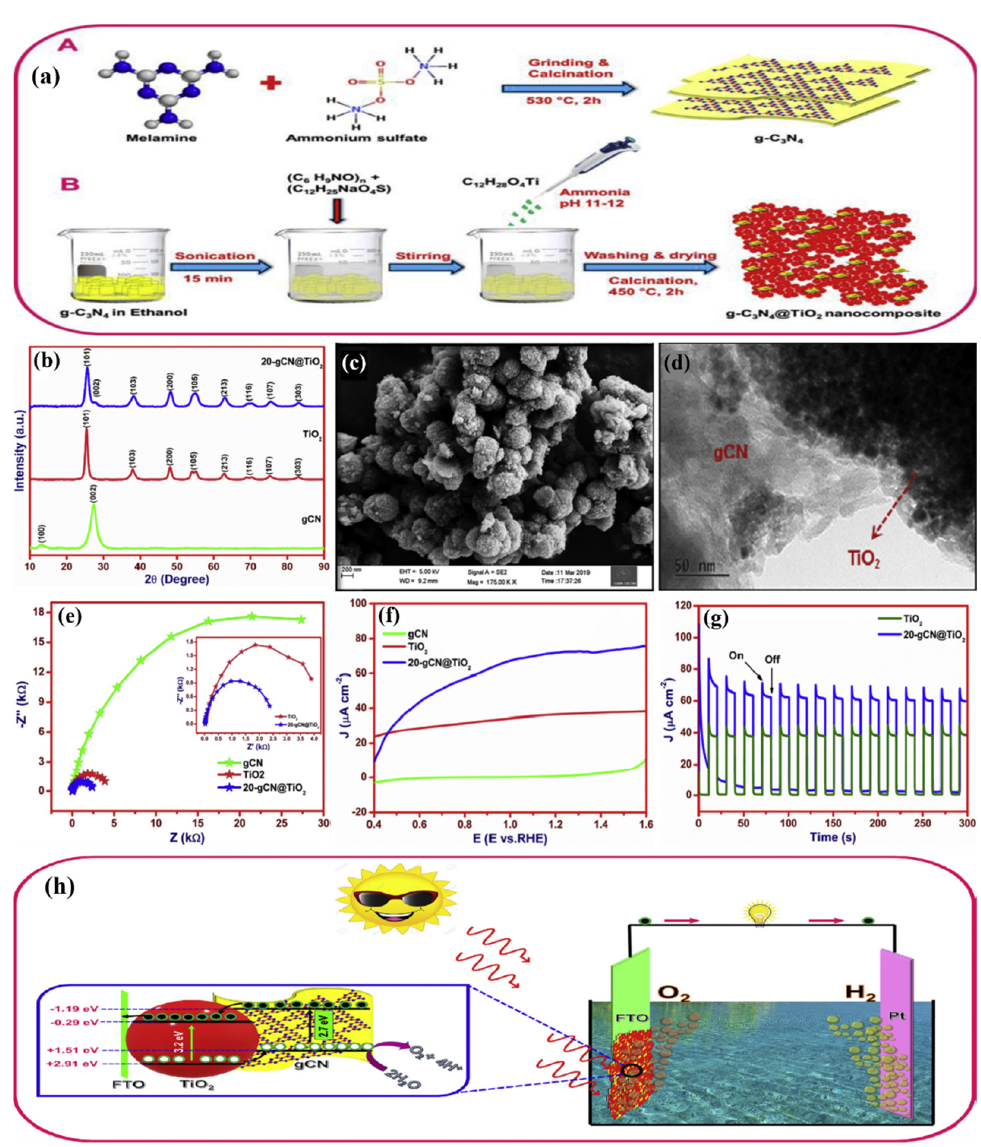
Figure 5. ( a ) Formation mechanism of CN@TO heterostructured material, ( b ) XRD patterns, ( c ) SEM image of 20-CN@TO material, ( d ) TEM image of 20-CN@TO material, ( e ) Nyquist plots, ( f ) LSV curves, ( g ) I-t curves, and ( h ) charge transfer mechanism of the CN@TO heterostructured electrodes. Reprinted with permission from reference [69], Copyright 2020, Elsevier.